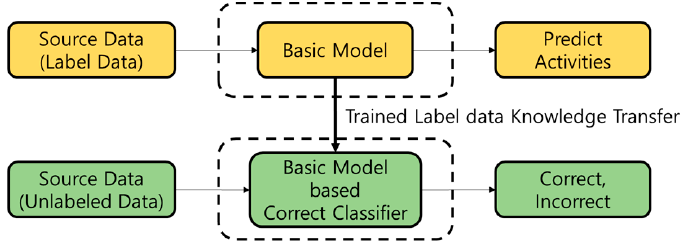
Figure 1. Transfer learning flow for labeling reduction.